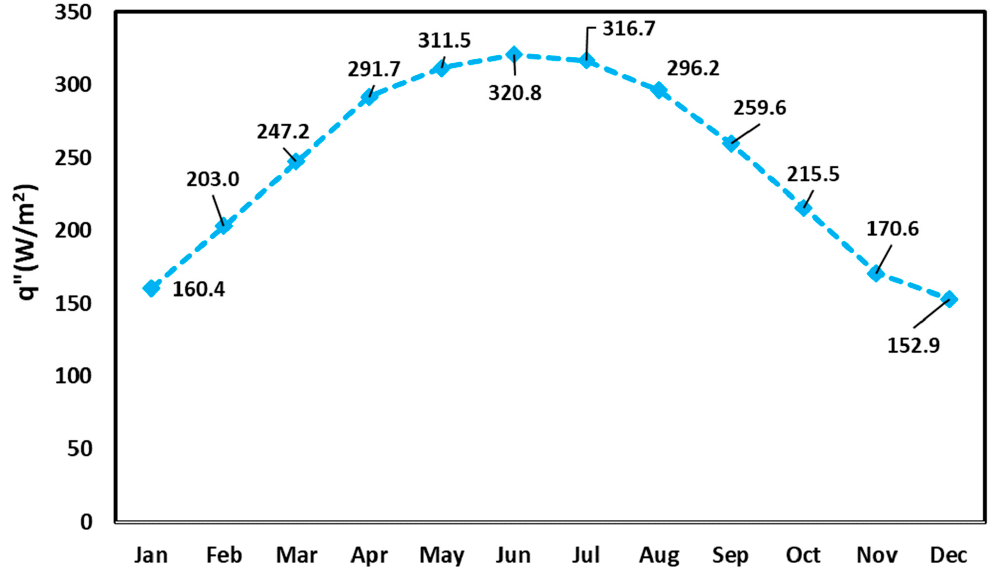
Figure 5. Monthly average solar radiation in di ff erent months of a year.